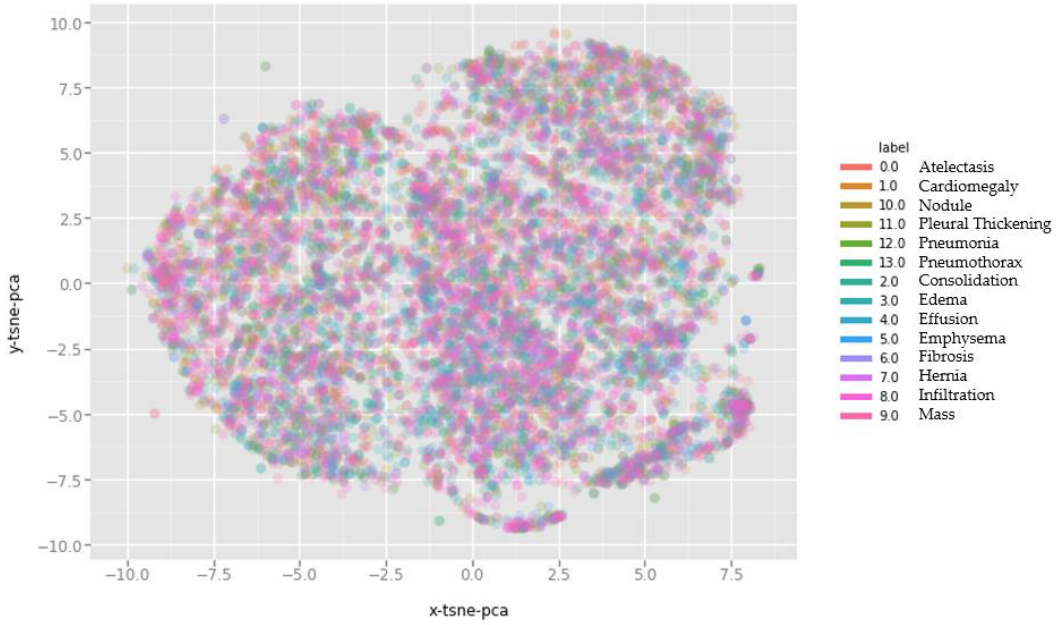
Figure 3. t-distributed stochastic neighboring entities (t-SNE) dimensions colored by digits with the usage of PCA.